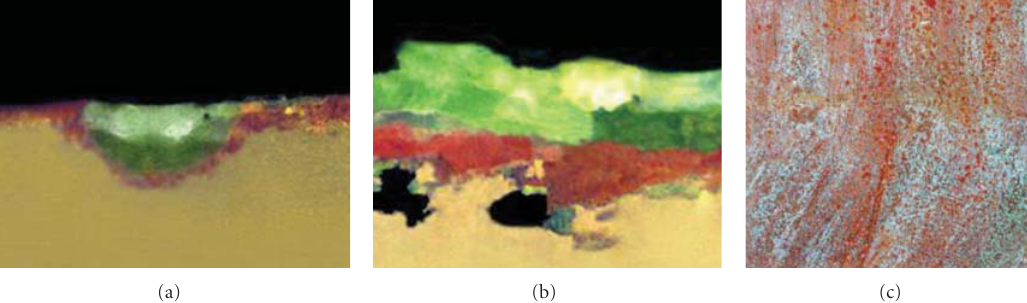
Figure 7: (a) Brochantite formation at discrete isolated clamps of crystals on the cuprite base layer formed in an urban atmosphere (cross- section view) [54]. (b) Brochantite formation on the cuprite base layer formed in a marine atmosphere (cross-section view) [54]. (c) Surface view of brochantite formation on the cuprite base layer formed in the marine atmosphere of Cojimar.